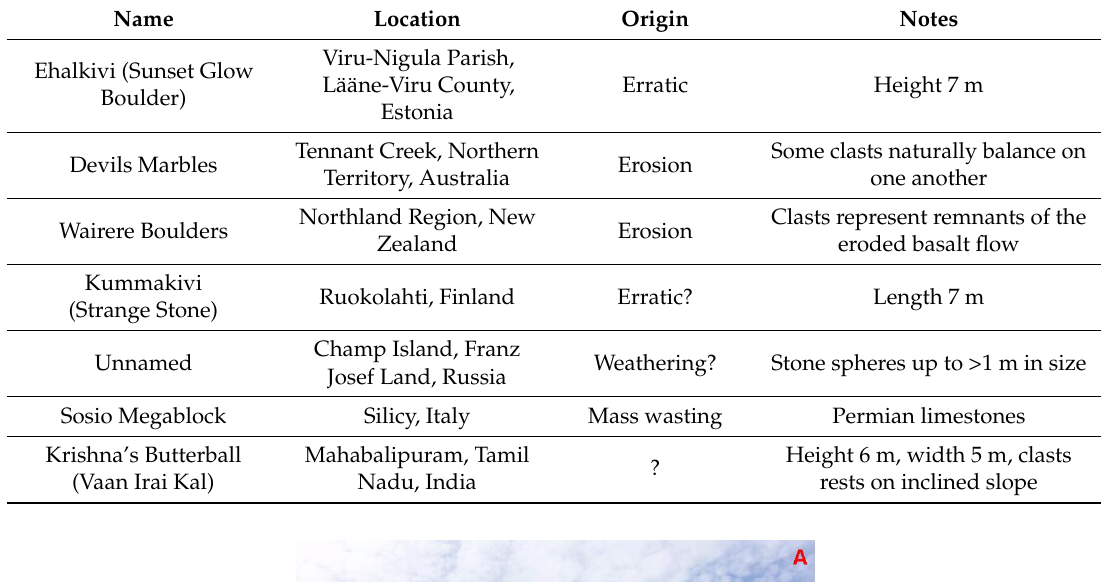
Table 3. Selected megaclasts used as tourist attractions.